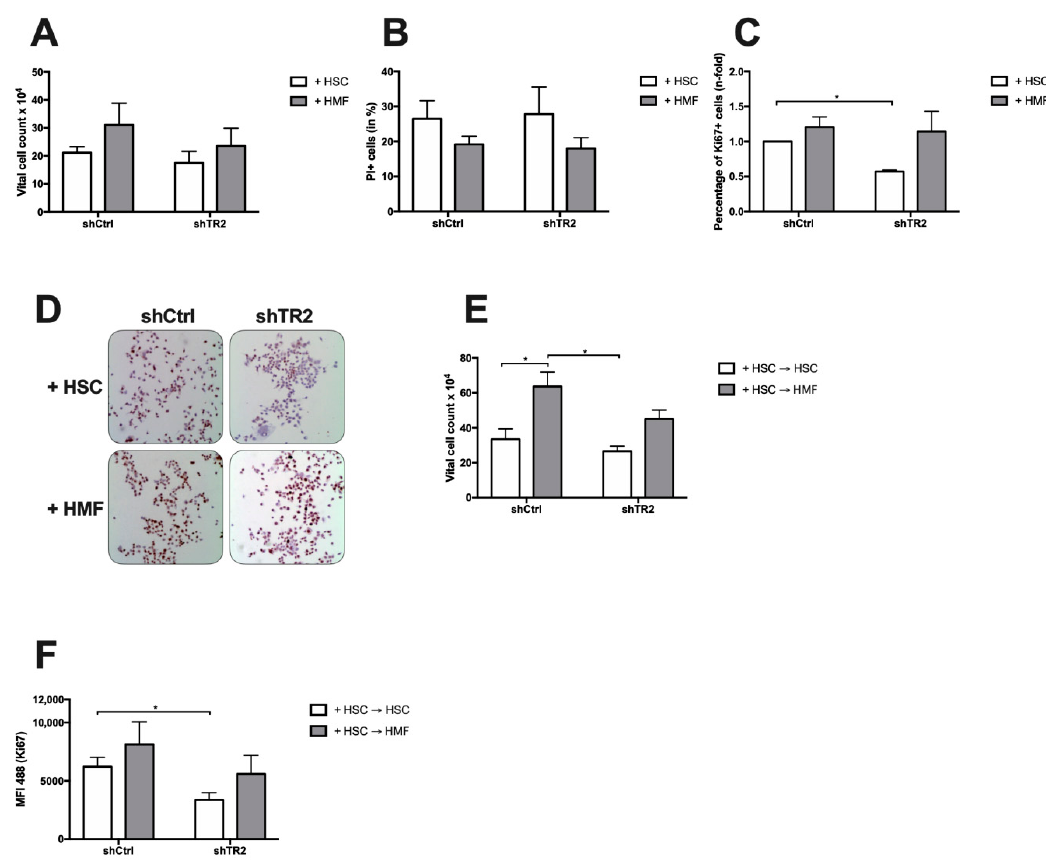
Figure 6. PancTu-I shTR2 cells show reduced cell growth in the presence of HSC in vitro. PancTu-I shCtrl or PancTu-I shTR2 cells were indirectly cocultured in the presence of HSC or HMF. After 6 days, ( A ) the vital cell number, ( B ) the proportion of PI + cells, and ( C) Ki67 + cells were determined. Vital cell numbers were obtained by counting living cells in a Neubauer counting chamber. The fraction of cells which underwent cell death was quantified by PI staining. The percentage of proliferating cells was determined by immunocytochemical Ki67 staining. ( D ) Representative images of Ki67 staining in PancTu-1 cells after different coculture conditions at 200-fold magnification. For extended coculture, HSC cocultured PancTu-I shCtrl and PancTu-I shTR2 cells were detached and re-seeded to extend the coculture either in the presence of HSC (HSC → HSC) or HMF (HSC → HMF). After another 6 days of coculture, ( E ) vital cell count and ( F ) the proportion of Ki67 + cells were assessed. The percentage of proliferating cells was determined by immunofluorescence Ki67-Alexa-488 staining. Data are expressed as median fluorescence intensity (MFI). Data represent the mean ± SEM of 3–5 independent experiments; * = p < 0.05.